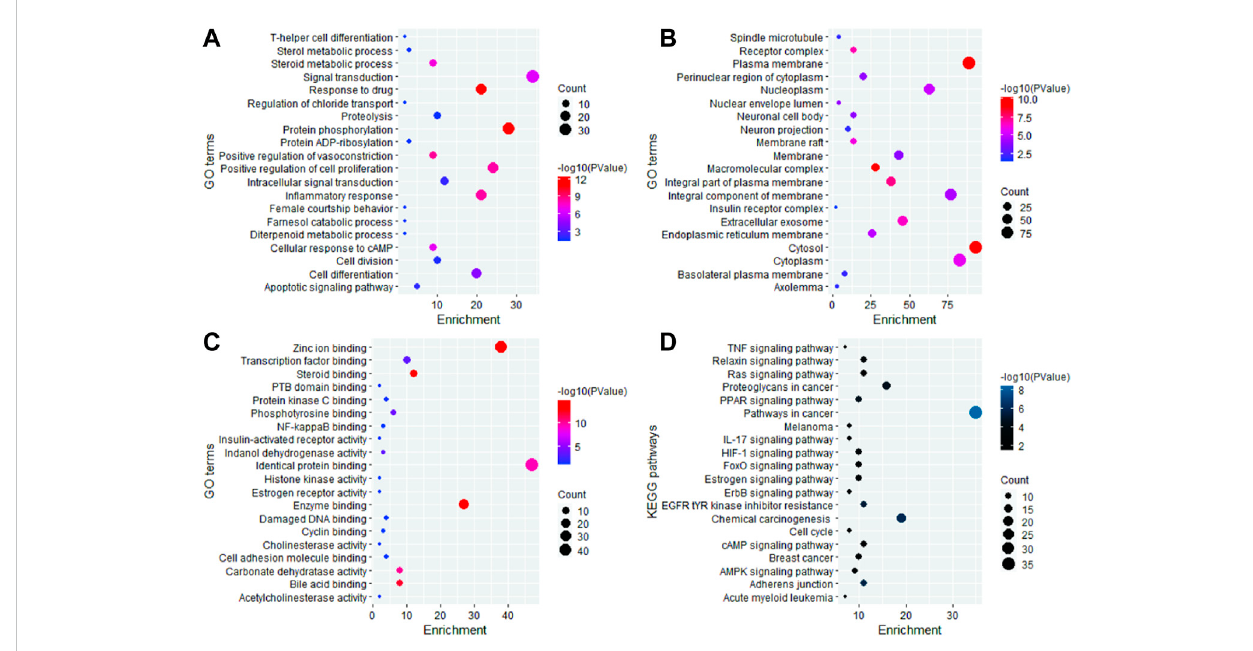
FIGURE 2 Graphical representation of the top 20 signi fi cant GO terms and KEGG pathways.